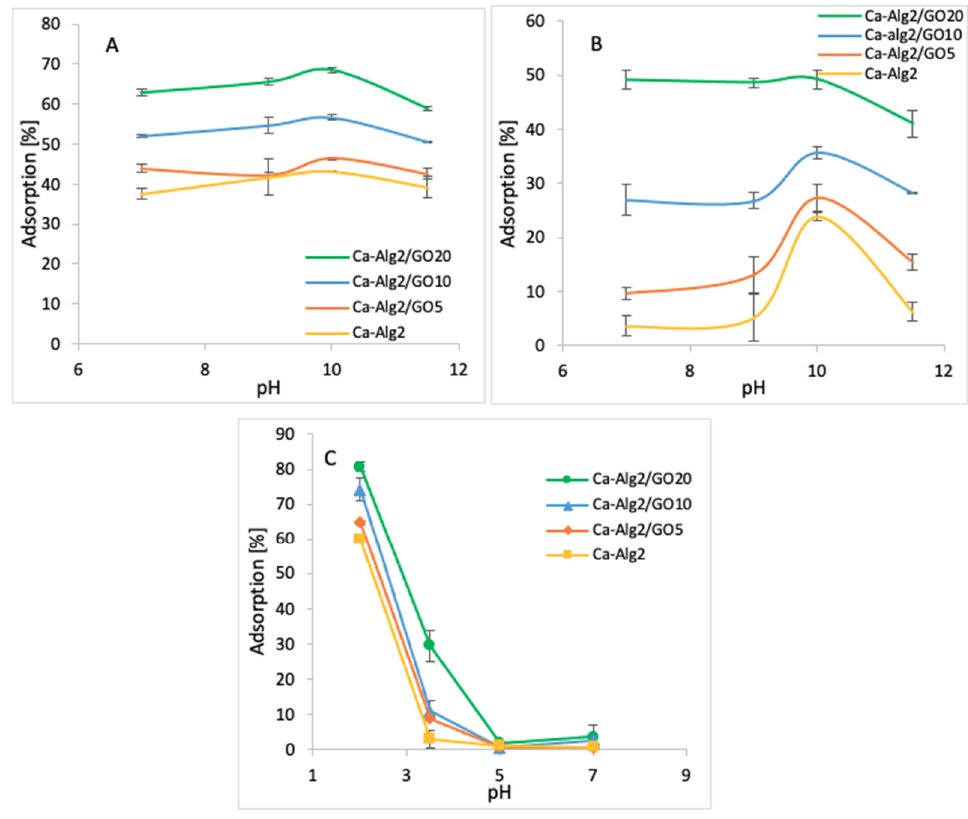
Figure 10. Effect of the pH on q eq MB ( A ), FMTD ( B ), DFC ( C